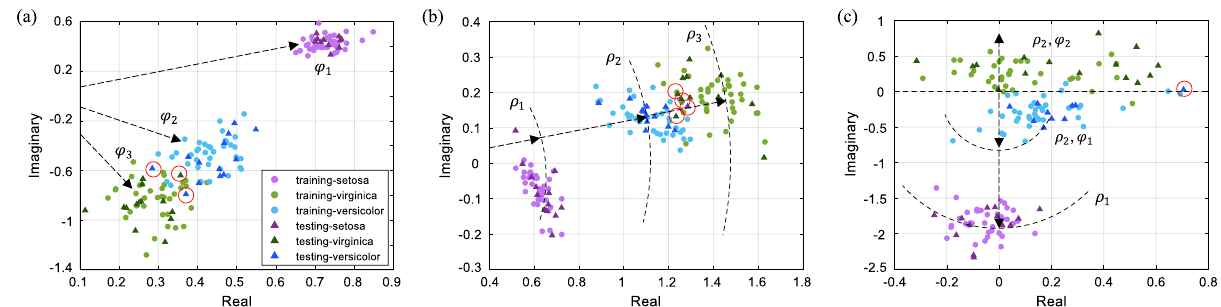
Fig. 4 A complex-valued layer for classi fi cation of dataset Iris . The ONC is recon fi gured with the complex-valued weight matrix trained for Iris task. The complex-valued neuron outputs are measured and displayed in two-dimensional Cartesian diagrams, as in a – c . The three shown cases are trained by three respective targets: phase only ( φ 1 , φ 2 , φ 3 ), magnitude only ( ρ 1 , ρ 2 , ρ 3 ) and their combinations ( ρ 1 , ( ρ 2 , φ 1 ), ( ρ 2 , φ 2 )). The circle markers are the validation results of training dataset while the triangle markers are those of the blind test instances. Data points which were wrongly predicted in the blind test are circled in red. It is shown by validation results that the optical chip identi fi es successfully the three species from the known data. While from testing results, we learn that the generalized model also fi ts well to